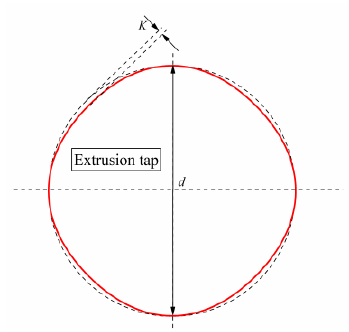
Figure 2. Extrusion tap profile line.